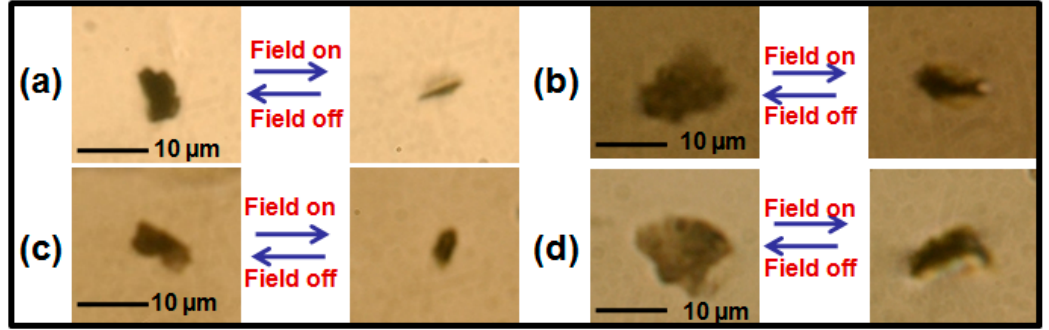
Figure 1. (Color online) Optical microphotographs exhibiting field-induced reorientation of representative GP flakes with similar flake areas and aspect ratios in low ( a , b ) and high ( c , d ) dielectric anisotropy nematic liquid crystal. ( a – d ) Case I: flake area and aspect ratio in ( a , b ): 35 µm 2 with an aspect ratio of 2:1 and 85 µm 2 with an aspect ratio of 1:1; Case II: flake area and aspect ratio in ( c , d ): 37 µm 2 with an aspect ratio of 2:1 and 90 µm 2 with an aspect ratio of 1:1.